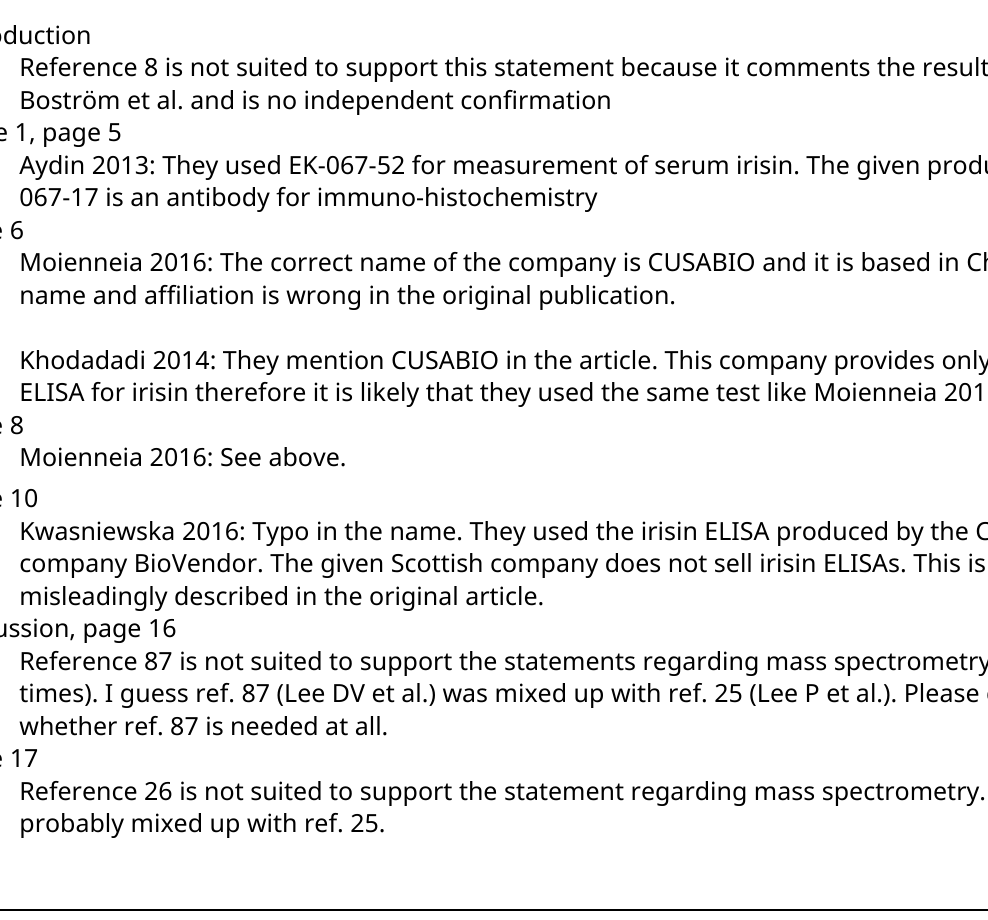
Aydin 2013: They used EK-067-52 for measurement of serum irisin. The given product H- 067-17 is an antibody for